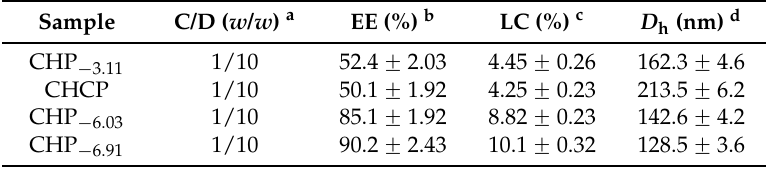
Table 1. Characteristics of self-aggregated nanoparticles loading mitoxantrone.